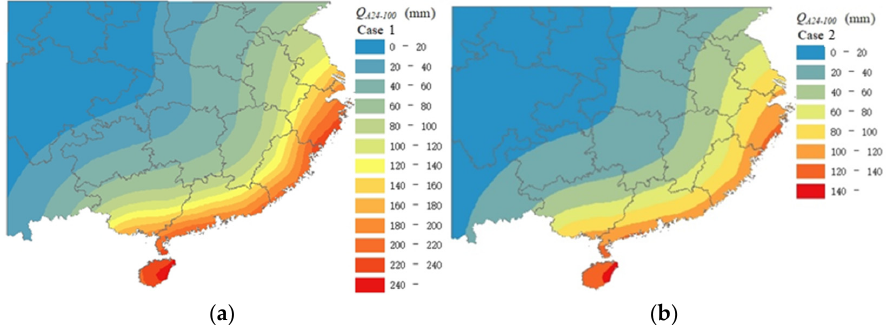
Figure 11. Mapped accumulated annual maximum rainfall hazard: ( a ) 100-year return period value of Q A 24 if rainfall intensity model for Case 1 is used and ( b ) 100-year return period value of Q A 24 if rainfall intensity model for Case 2 is used.